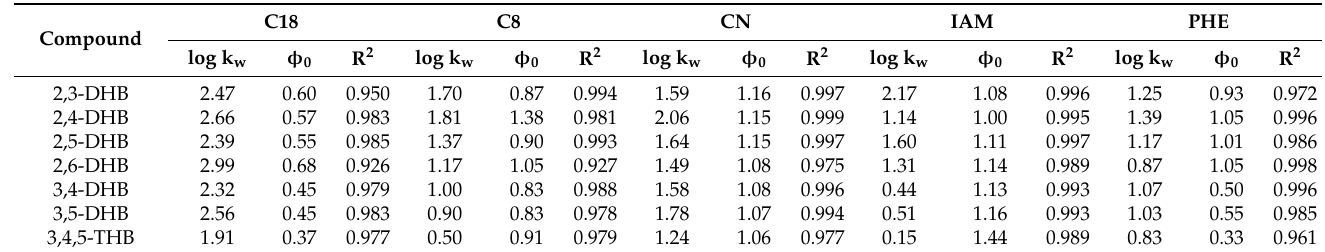
Table 6. Lipophilicity parameters determined by chromatographic methods (the logarithm of the retention factor, log kw ) and octanol/water partition coefficients logP obtained for hydroxybenzoic acids. Compound